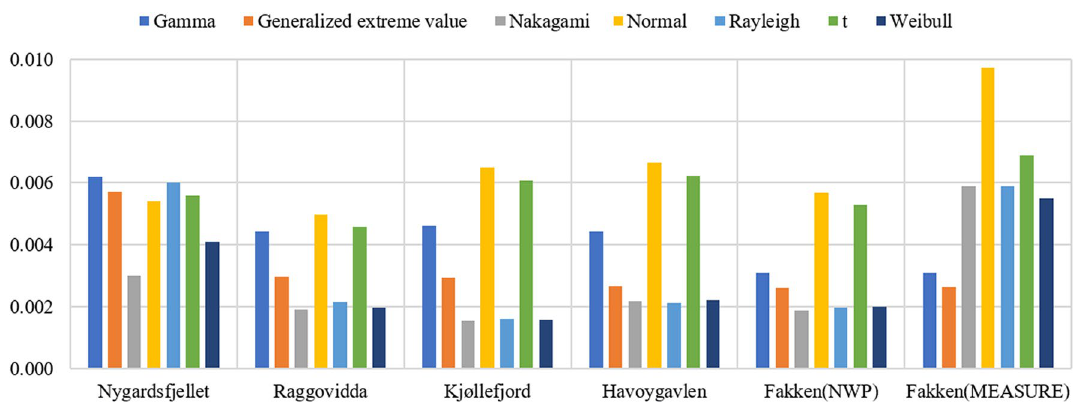
Figure 2. The overall MAE of wind speed PDFs for NWP data from five sites and measurements from Fakken.